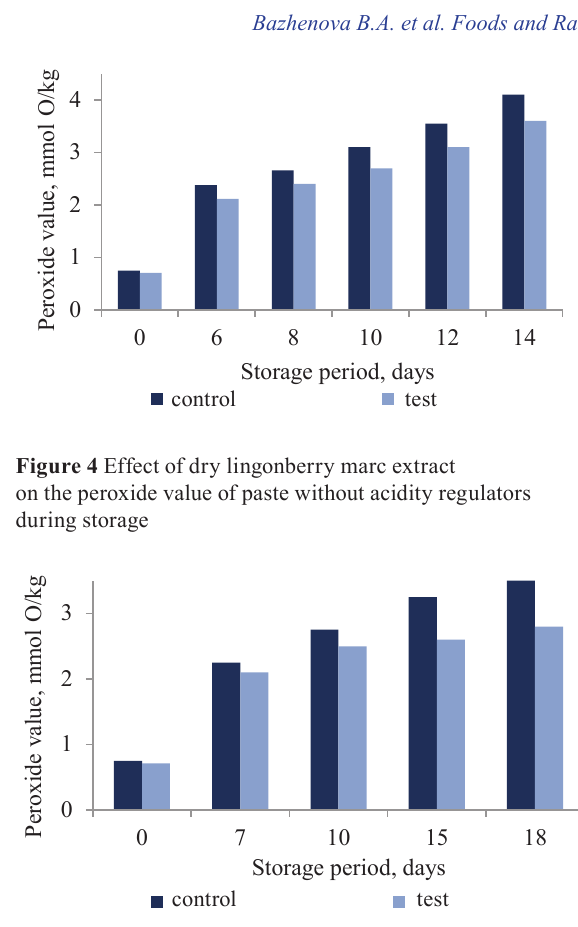
Figure 5 Effect of dry lingonberry marc extract on the peroxide value of paste with sodium lactate during storage